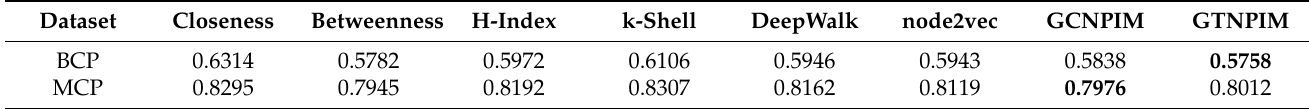
Table 4. Comparison of models on robustness R.